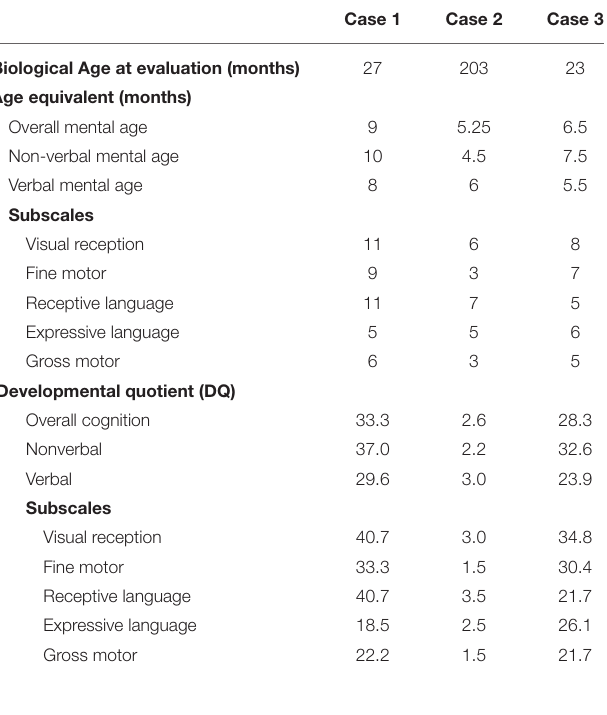
TABLE 2 | The evaluation of Mullen Scales of Early Learning (MSEL) of Subjects with FOXG1-related syndrome.